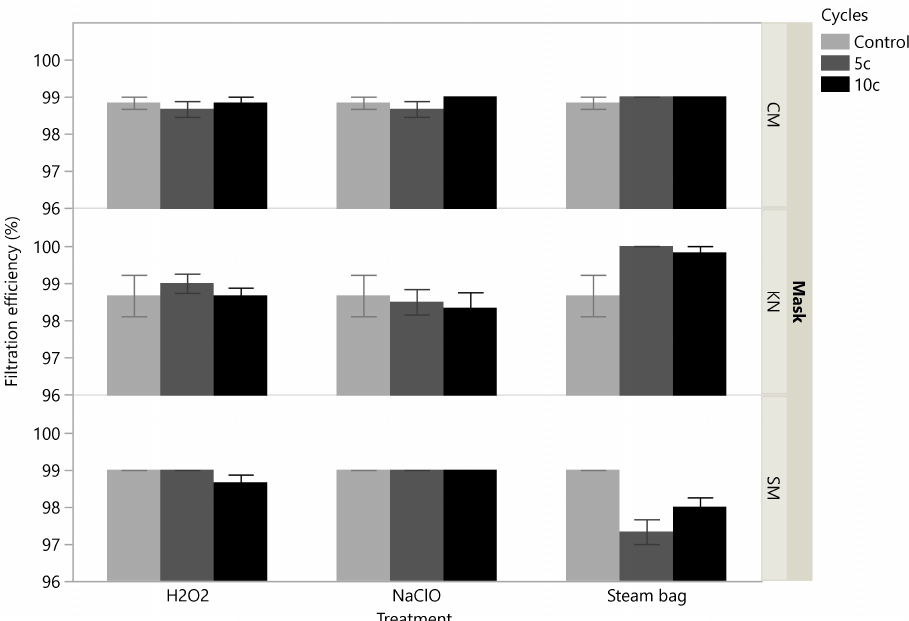
Figure 4. Experimental results obtained for the filtration efficiency, stratified according to the type of mask (CM, KN, SM) and decontamination treatment (H 2 O 2 , NaClO, Steam Bag). Each bar corresponds to the mean of all measurements obtained for each level of cycles (6 replicates); the error bars depict the standard error of the